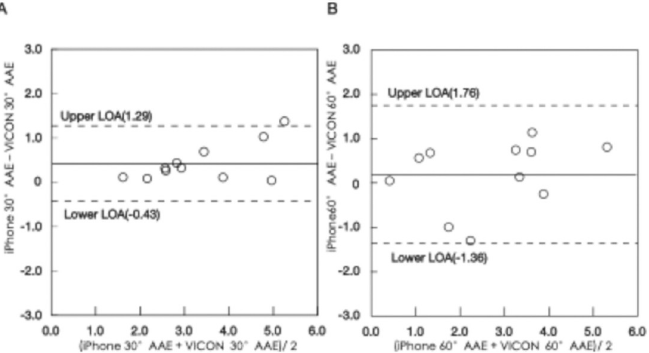
Fig 3. Bland-Altman plots. Mean values (continuous line) and LOA (dotted line) are shown on the Bland-Altman plots. AAE: absolute angular error; LOA: limits of agreement. (A) 30˚ AAE values measured with iPhone and VICON. Y-axis: Difference between the iPhone 30˚AAE and VICON 30˚AAE. X-axis: Average of both measures. Difference mean: Bias between the iPhone 30˚AAE and VICON 30˚AAE. LOA at 95% confidence intervals. (B) 60˚AAE values measured with iPhone and VICON. Y-axis: Difference between the iPhone 60˚AAE and VICON 60˚AAE. X-axis: Average of both measures. Difference mean: Bias between the iPhone 60˚AAE and VICON 60˚AAE. LOA at 95% confidence